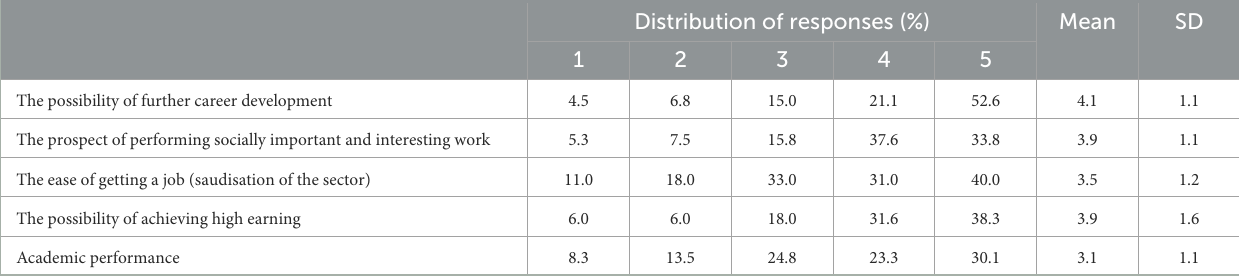
TABLE 3 Distribution of perceptions about medical representative career pathway, from 1 (strongly disagree) to 5 (strongly agree).